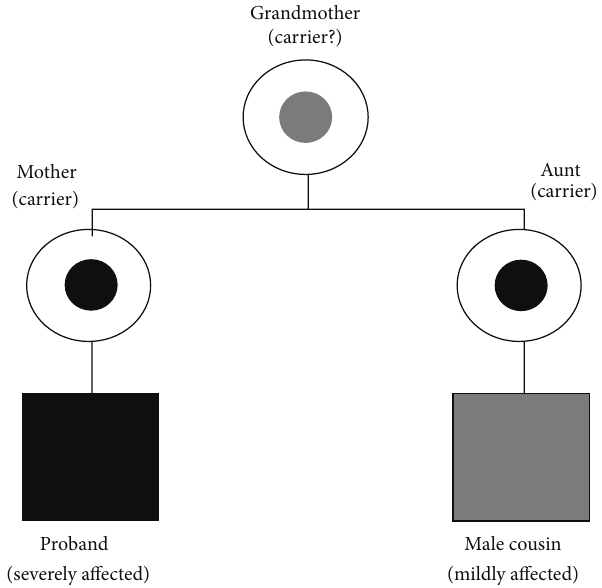
Figure 4: Pedigree of family in present study. Squares and circles represent males and females, respectively. Blackened symbols indi- cate individuals with X-linked Opitz syndrome confirmed by MID1 mutation analysis. Gray-coloured symbols indicate individuals with a suspected mild form of X-linked Opitz syndrome, not confirmed by MID1 mutation analysis. Small black dots within the circle indicate carrier state confirmed by MID1 mutation analysis. Small gray dots within the circle indicate carrier state not confirmed by MID1 mutation